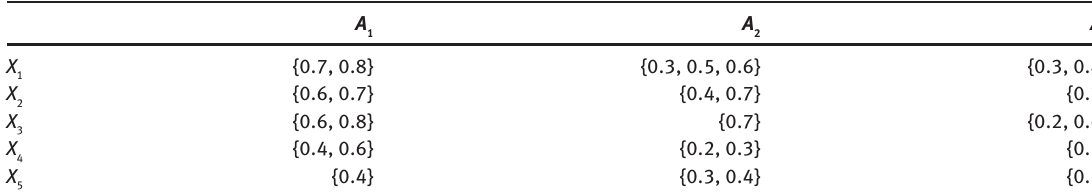
Table 5: Ordered Hesitant Fuzzy Decision